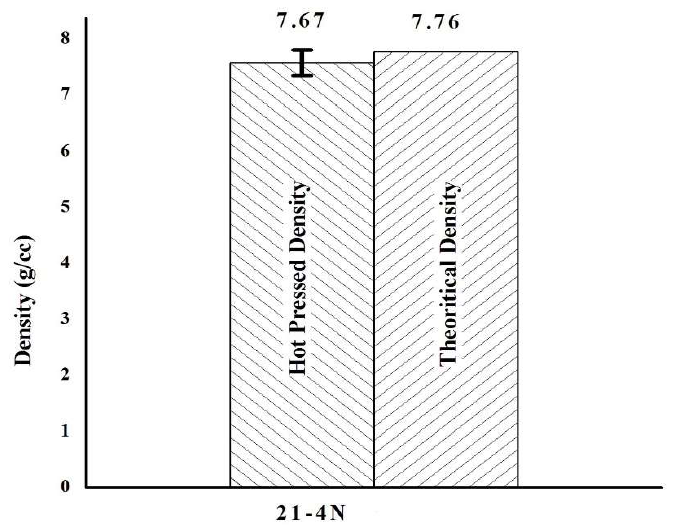
Figure 4. Density of hot pressed samples developed through powder metallurgy route.